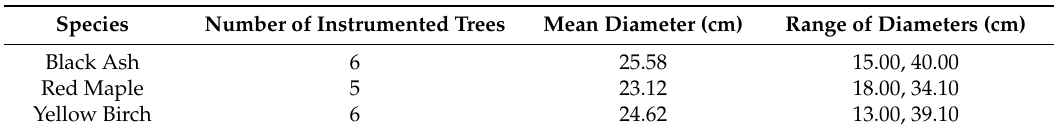
Table 1. Number of trees instrumented for sap flux measurements along with mean diameter and diameter ranges of instrumented